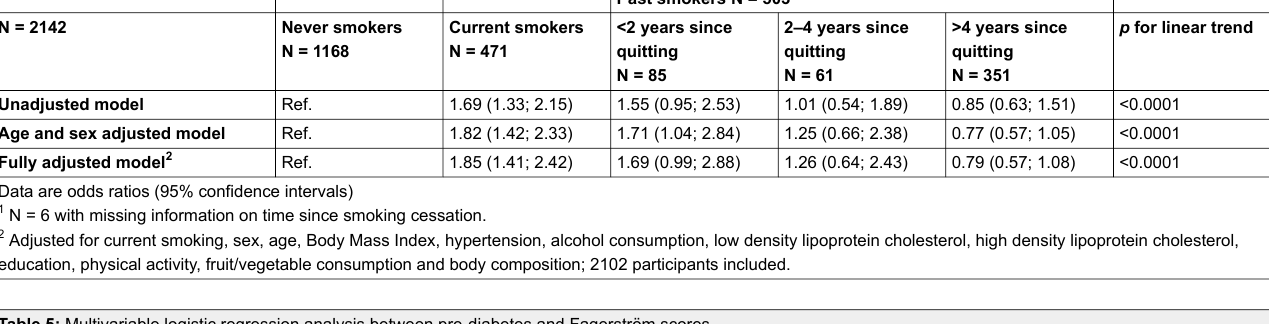
Table 5: Multivariable logistic regression analysis between pre-diabetes and Fagerström